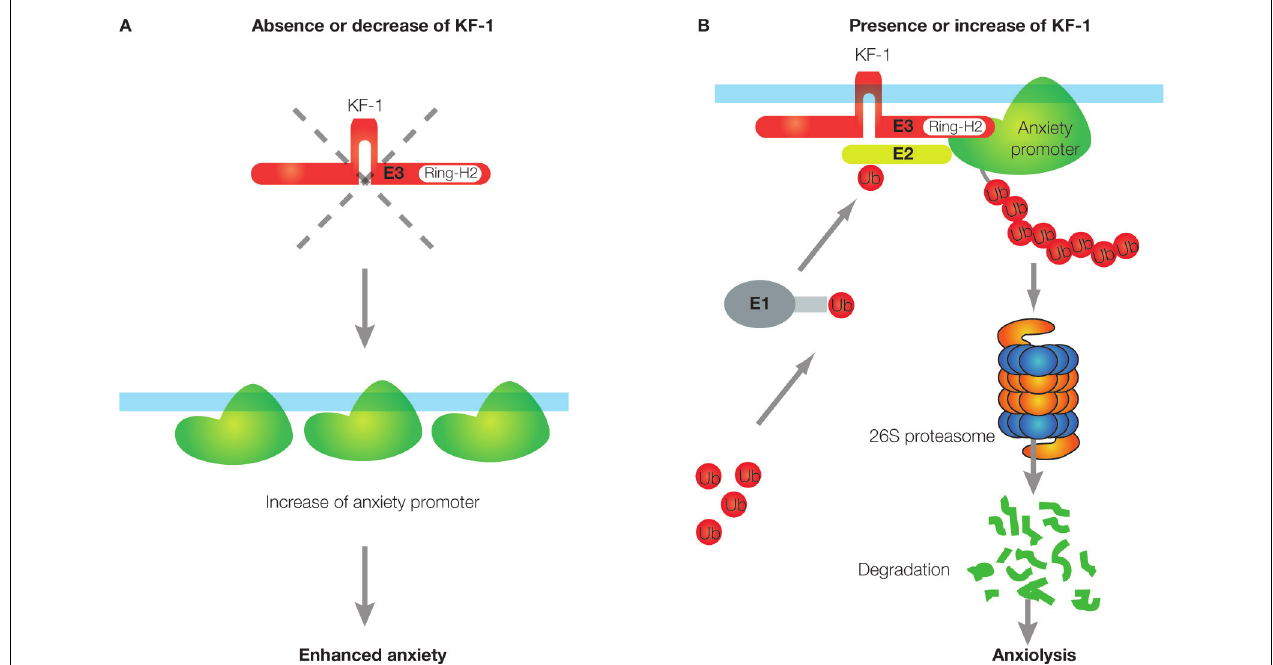
promoter will be degraded or lost due to 26S proteasomal degradation through the KF-1 mediating ERAD pathway, resulting in ‘anxiolysis’. ‘Ub’ represents the ubiquitin molecule. ‘E1’, ‘E2’, and ‘E3’ represent the ubiquitin-activating enzyme, ubiquitin-conjugating enzyme, and ubiquitin ligase,